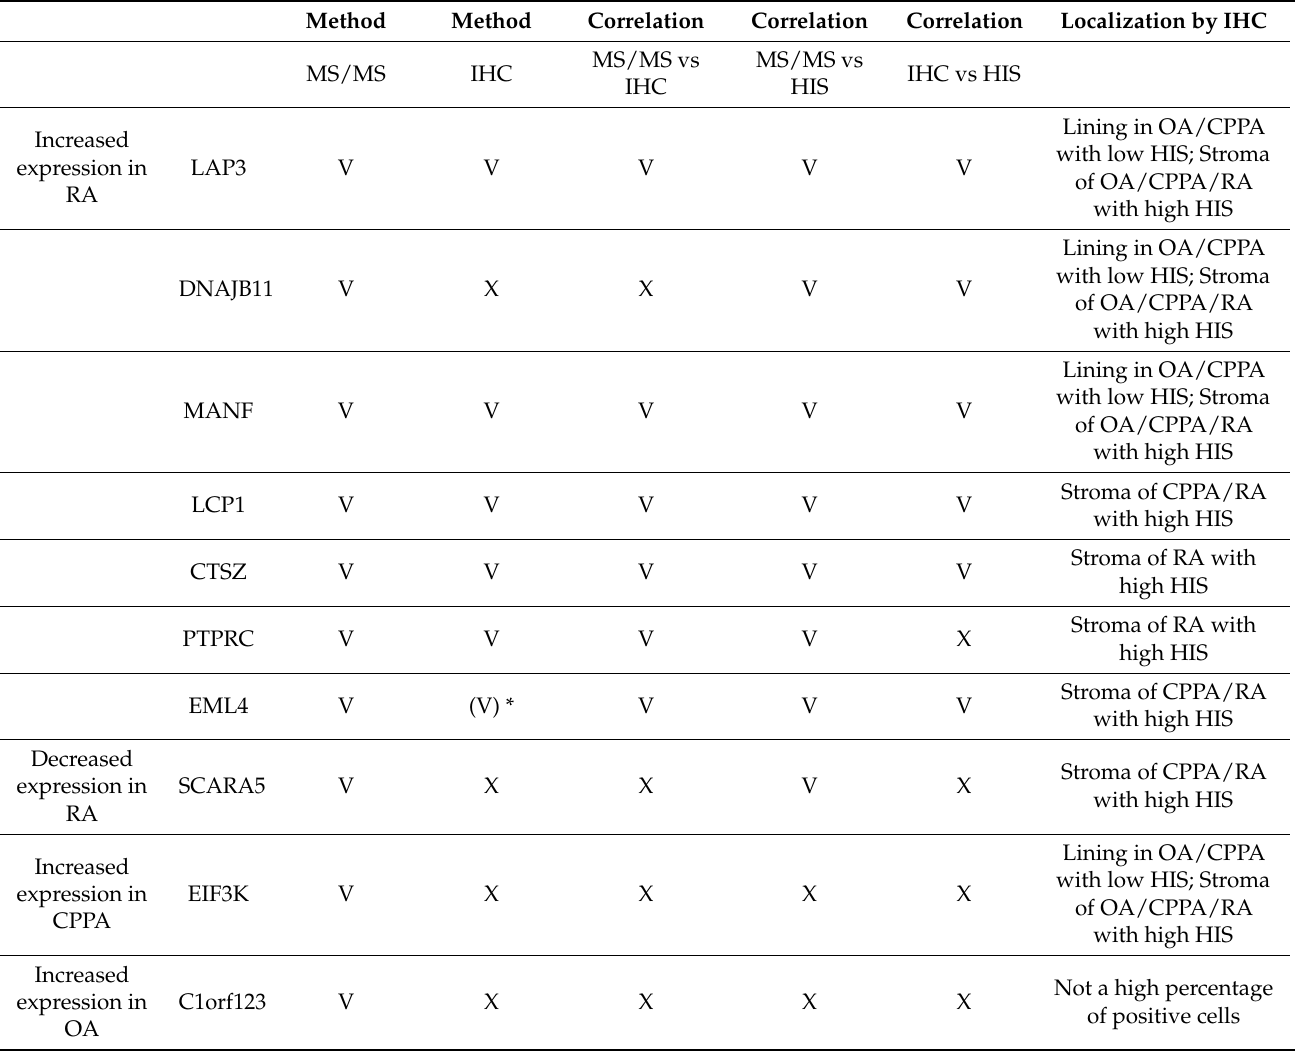
Table 2. Overview table related to the 10 highlighted proteins. Summary concerning modulated protein expression detected by mass spectrometry (MS/MS) or immunohistochemistry (IHC) and correlated to the histological inflammatory scoring (HIS). “V” means detected by the method or correlated; “X” means not detected by the method or not correlated. * Not